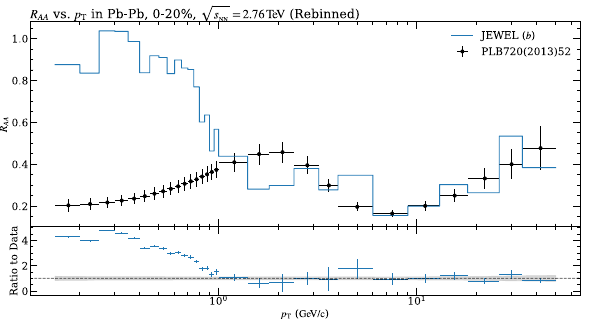
Fig. 7 Nuclear-modification factor R AA measured by ALICE [39] compared to Jewel model calculations. The region below 1GeV / c is not attempted to be modelled correctly in Jewel resulting in the large discrepancy. Note, that data and MC have been rebinned to allow a reasonable